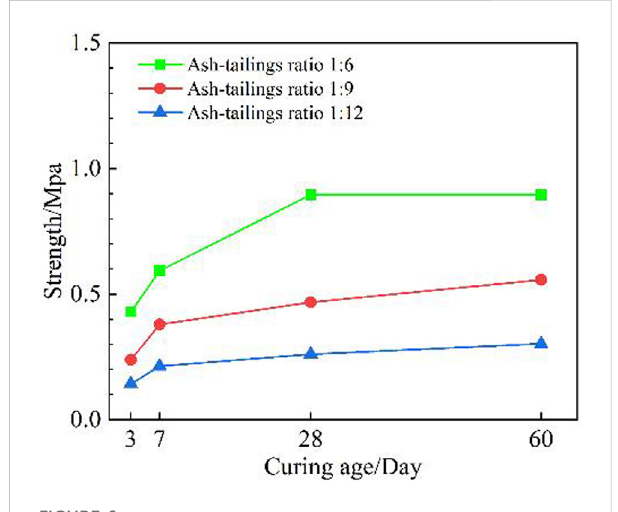
FIGURE 6 Variation of the strength of back fi ll materials for 46% concentration with the ash-tailings ratio.